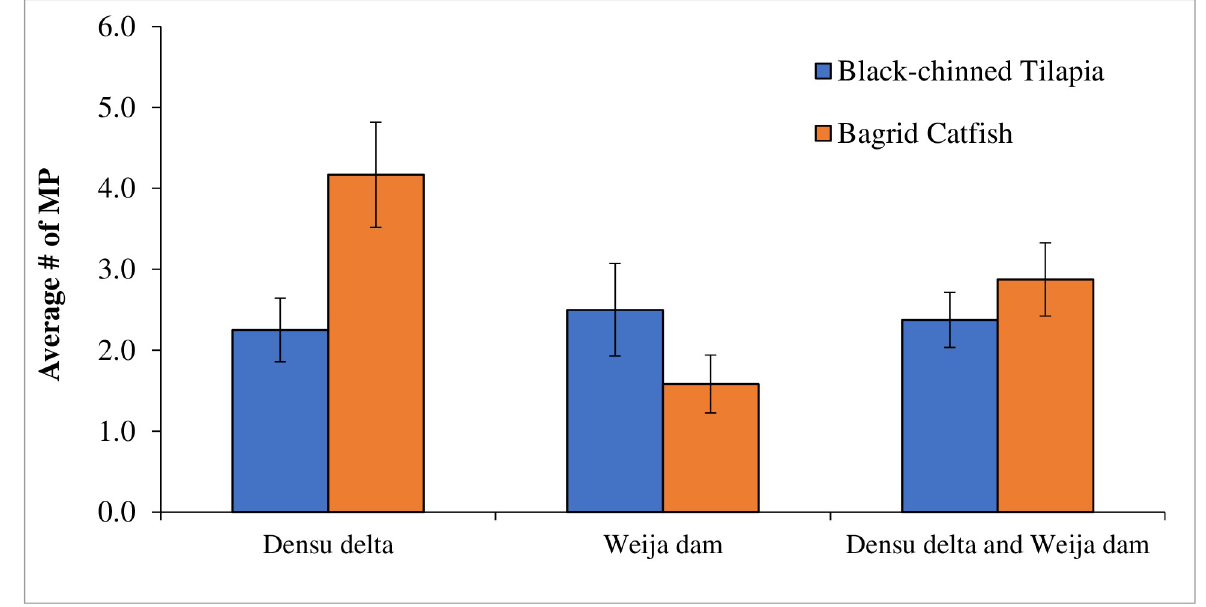
Fig 3. Number of microplastics in the gut of Black-chinned Tilapia and Bagrid Catfish in the Densu Delta and Weija Dam in Ghana.